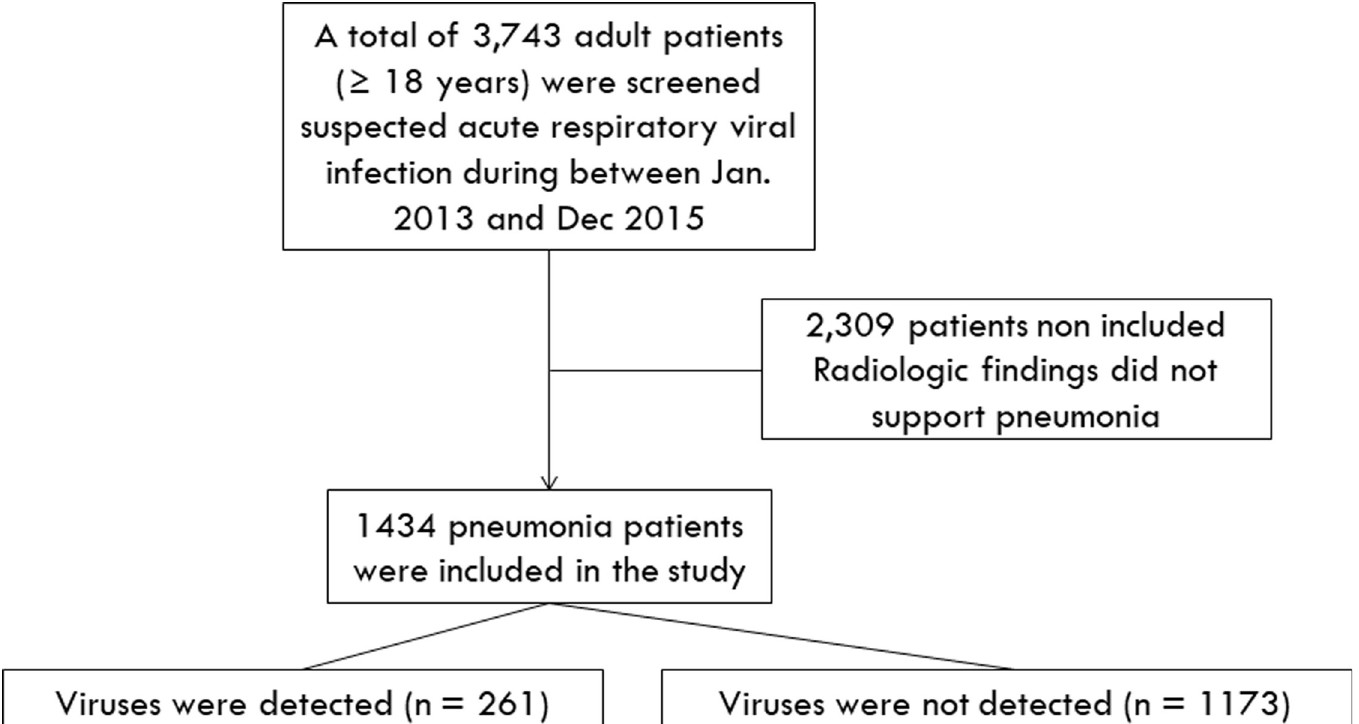
Fig 1. Flow chart of patients who had